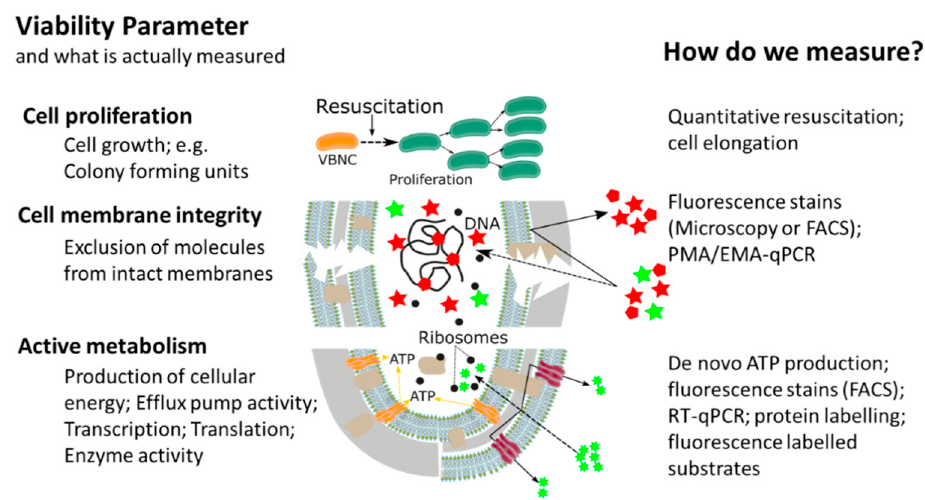
Figure 2. Overview of currently available methods for measuring different bacterial cell viability parameters, adapted from [34].